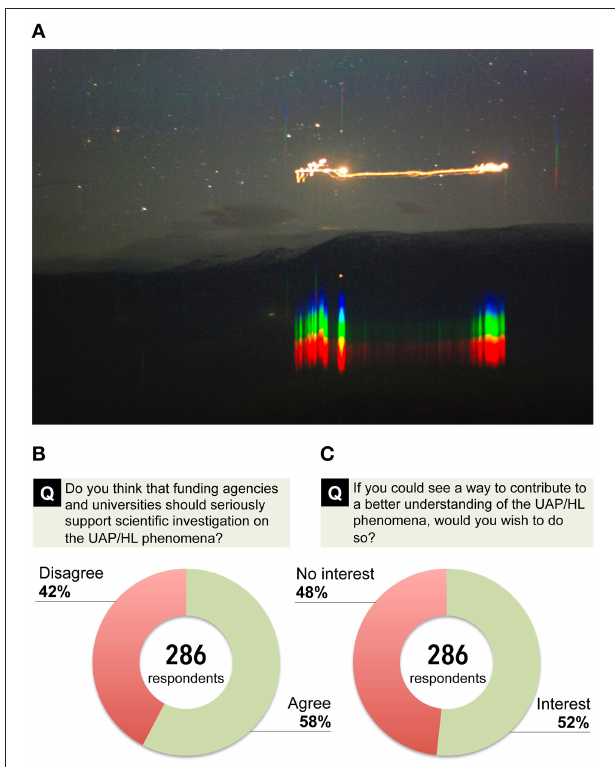
FIGURE 1 | Researchers who are past or current beneficiaries of funding from the European Commission were asked (1) whether or not funding agencies and universities should support scientific investigation on UAP such as HL, and (2) whether or not they would like to contribute to a better understanding of UAP/HL if they could see a way to do it. (A) Hessdalen phenomena and visualization of the visible light spectrum. The phenomenon was photographed from the Rogne mountain toward west at 21:58, 20th September 2007. Exposure time 30s, Nikon D80, 50mm f/1.8, 1600ASA. Transmission grating attached to camera (from Hauge, 2010, copyright 2010, with permission from Elsevier). See the supplementary video showing the fragmentation of HL in a linear cluster of light balls: https://www.youtube.com/watch?v = fSgPBOBSJrI ( Paiva and Taft, 2012b ) (B) Proportion of respondents who agree or disagree with further funding support for scientific investigation on UAP/HL. (C) Proportion of respondents showing an interest in contributing to UAP/HL